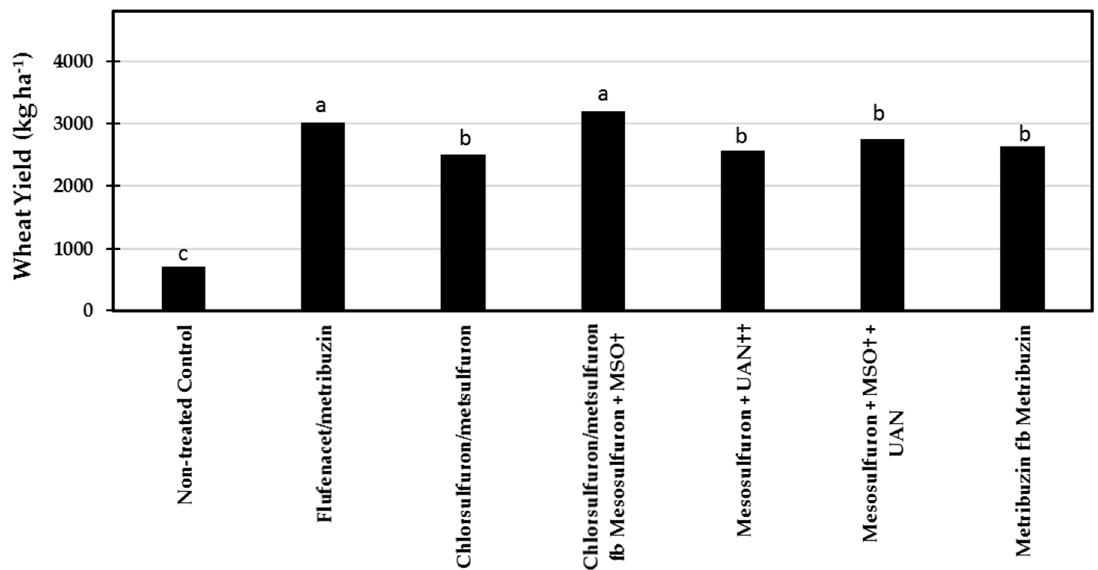
Figure 1. Wheat yield as affected by herbicide treatments used from 2001 to 2004. MSO is methylated seed oil applied at 1% v/v. UAN (Urea Ammonium Nitrate) is a fertilizer additive applied at 1.25% v/v. fb means followed by. A similar letter on bars indicate no statistical difference at p ≤ 0.05.